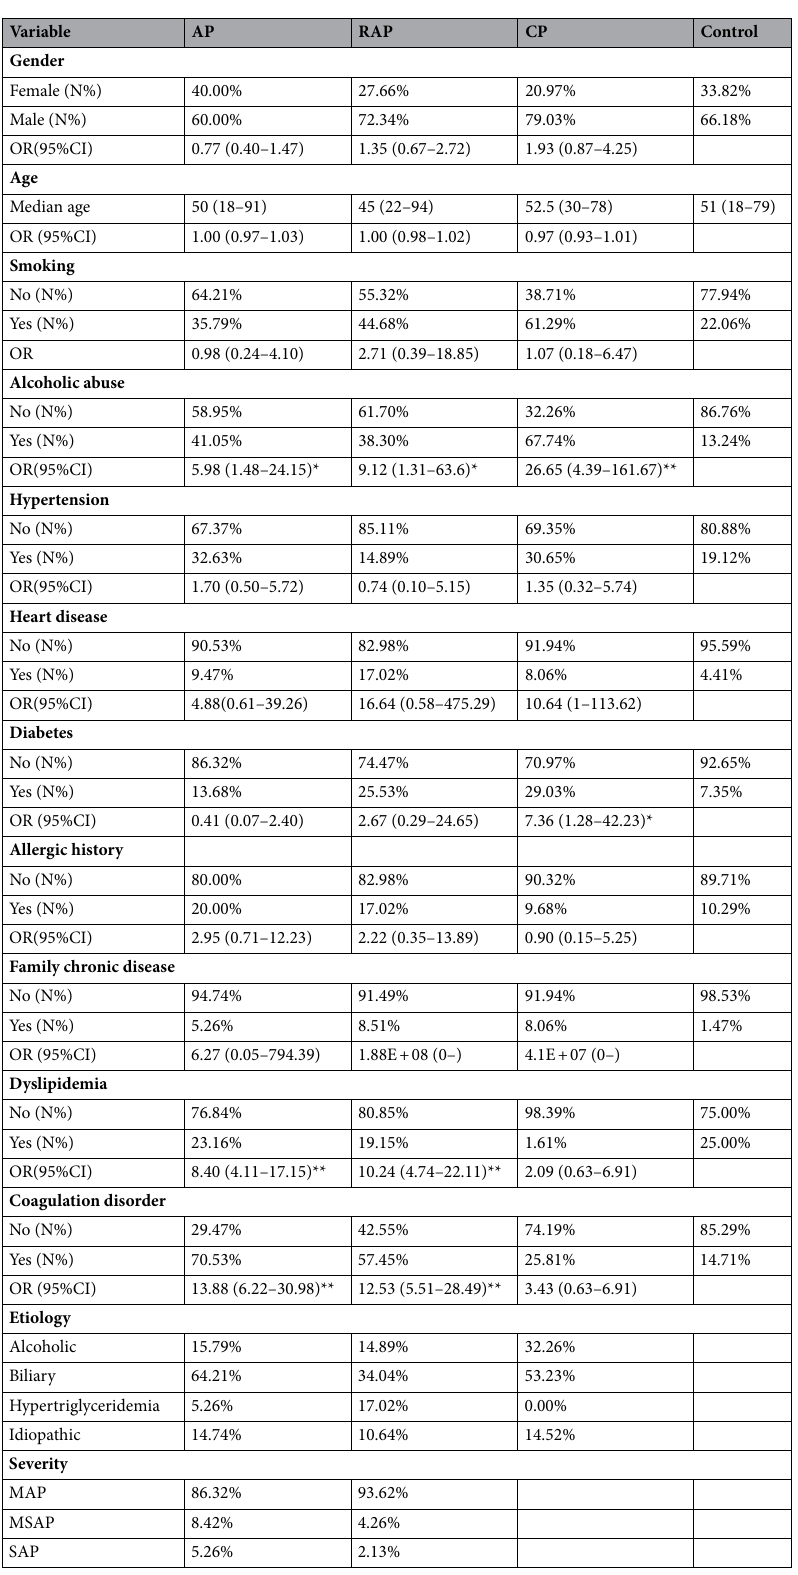
Table 1. Patients’ characteristics and predictors by univariate analysis in different types of pancreatitis. AP acute pancreatitis, RAP recurrent acute pancreatitis, CP chronic pancreatitis. *p < 0.05; **p <